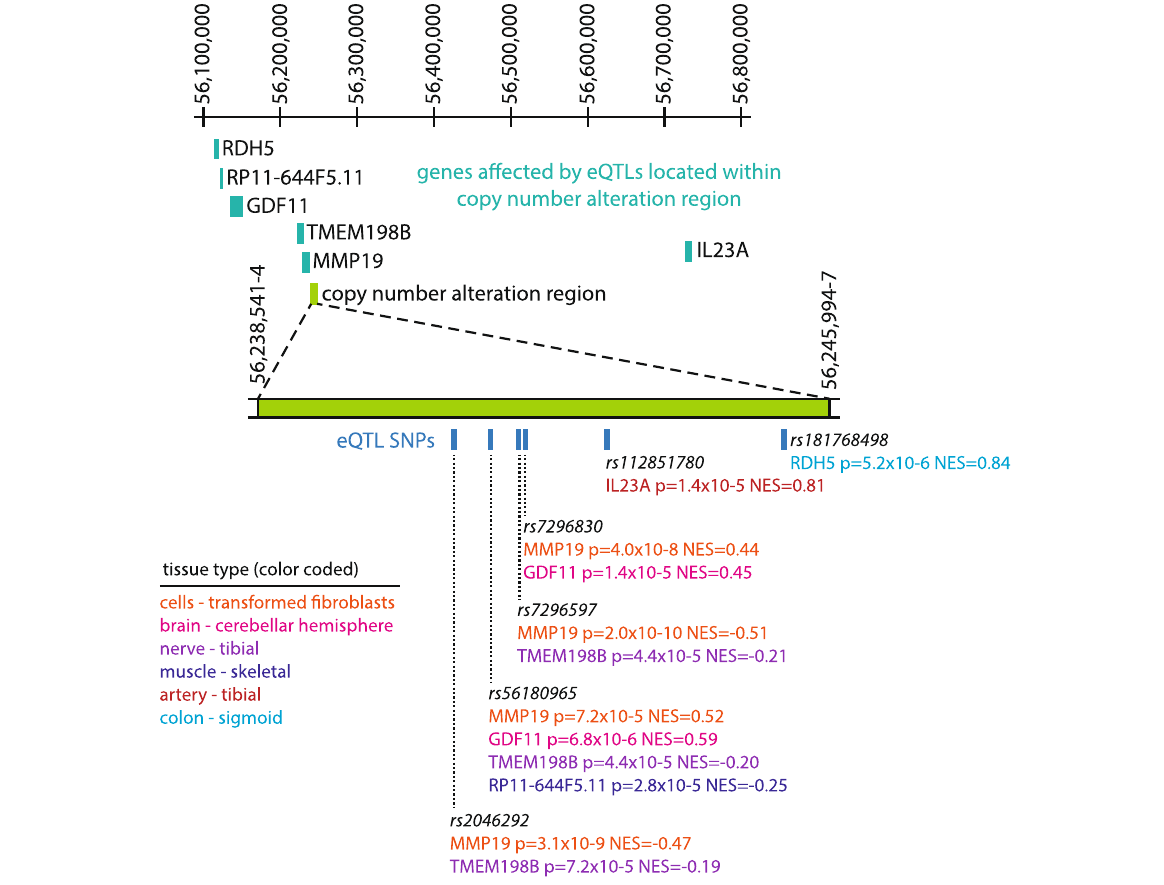
Fig. 5 Locations of expression quantitative trait loci (eQTLs) within the copy number alteration region. Single nucleotide polymorphisms (SNPs) are mapped out within the copy number alteration region with color coding indicating the tissue type in which they are found to act as